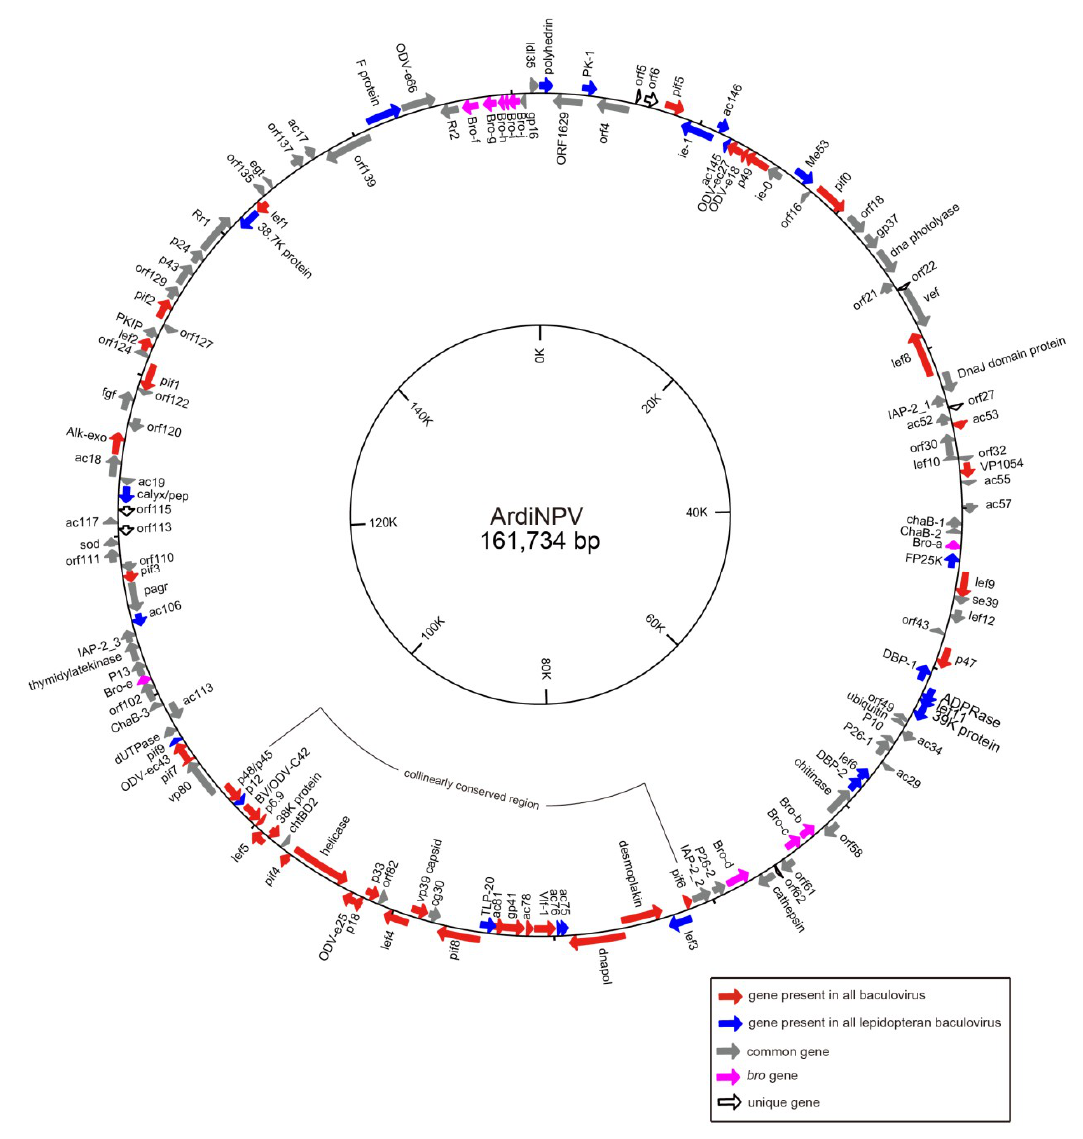
Figure 1. Whole-genome map of ArdiNPV. The gene transcription orientations are indicated by arrows, which depict ORFs. The gene types are colored as follows: red = core genes, blue = lepidopteran baculovirus conserved genes, gray = other baculoviral common genes, open arrows = unique genes of ArdiNPV, and purple = bro genes. The inner-circle indicates the gene locations. The collinearly conserved region of lepidopteran baculoviruses is also